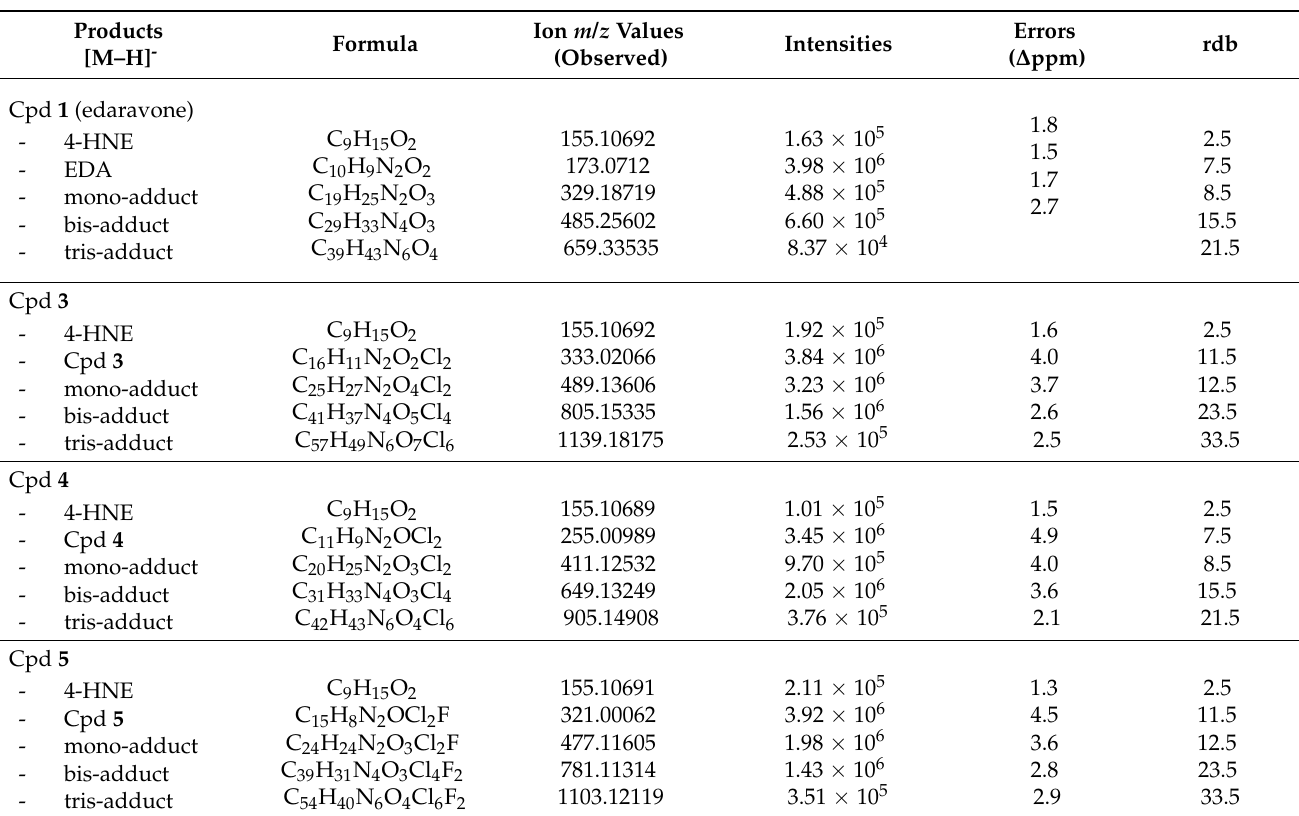
Table 3. HRMS analysis of the reaction of the compounds with 4-hydroxynonenal (4-HNE).